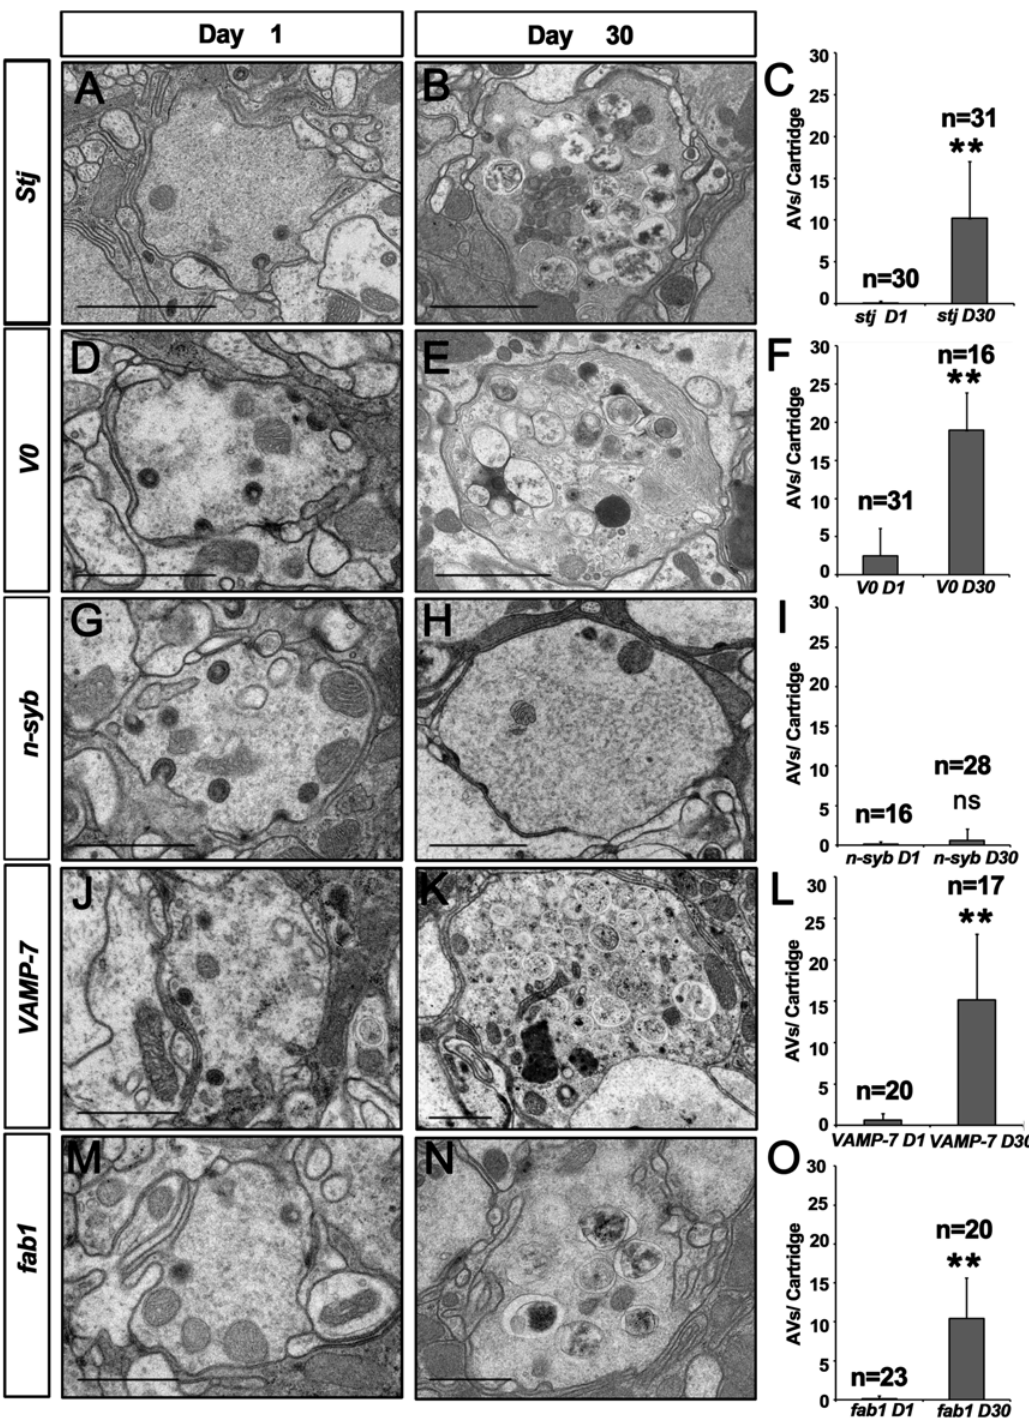
Fig 3. Autophagy defects observed in cac mutants are not due to defects in neurotransmitter release, but due to defects in lysosomal fusion. TEM sections of 1-day-old and 30-days-old photoreceptor terminals of flies raised in 12 h light/dark conditions. A, B, D, and E. stj and Vha100 – 1 (V0) mutant terminals accumulate AVs upon aging. G, H. n-Syb mutant photoreceptor terminals show increased SVs, but not a significant accumulation of AVs and fusion-primed AVs. J, K, M and N. Vamp7 and fab1 mutant photoreceptor terminals show the highest increase in AV accumulation. C, F, I, L, O. Quantification of the different AVs for each genotype ( ** : p < 0.01). Eyes from three animals for each genotype at each age were analyzed and the counted cartridge number were listed as “ n = ” in the figure. Data are presented as means ± standard deviation (SD). Scale bars, 1 μ m.